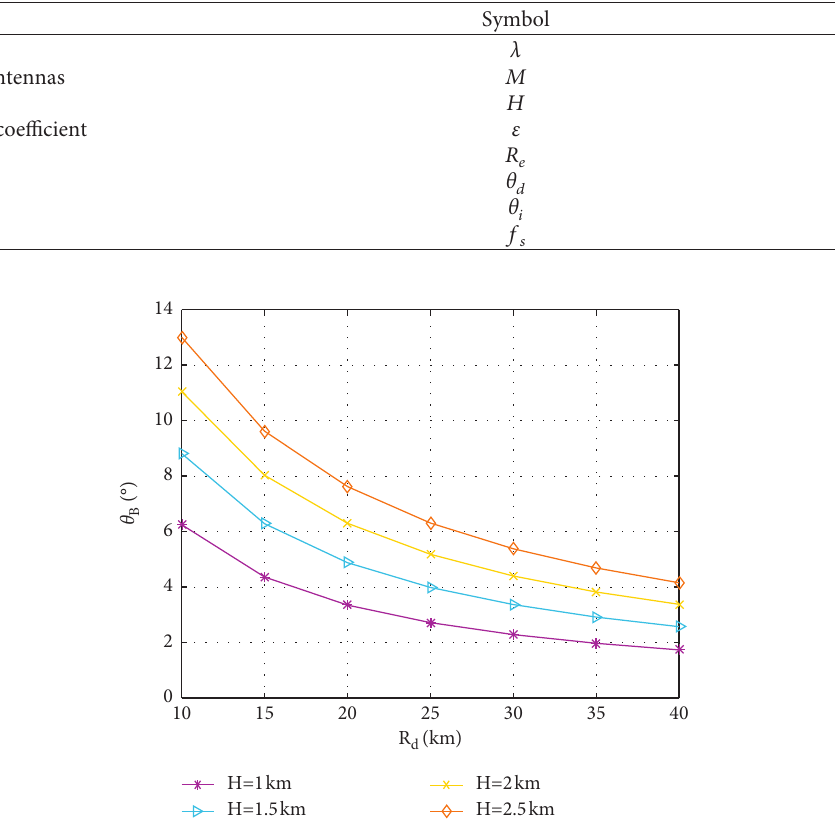
Figure 4: The relationship between the angle θ